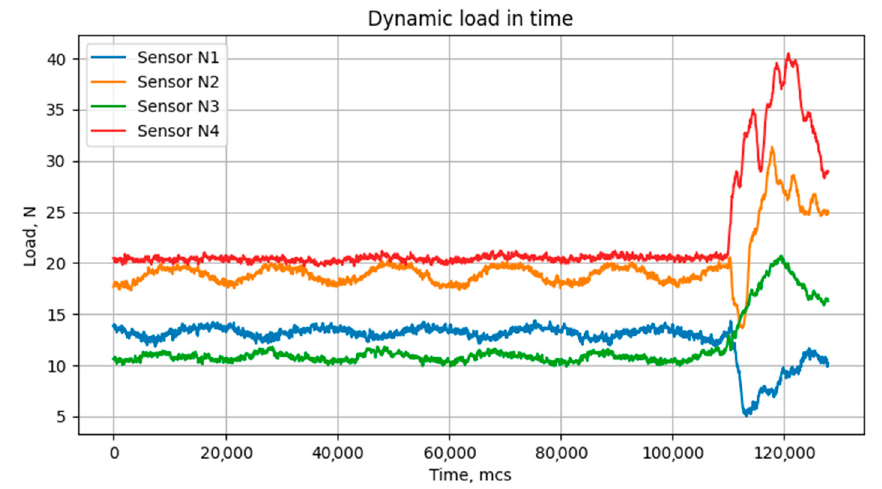
Figure 12. Increasing the signal value derivative for each of four strain gauge sensors. To automatically detect a sharp increase in the signal value derivative, the following criteria are suggested:  kRR averagecritical 